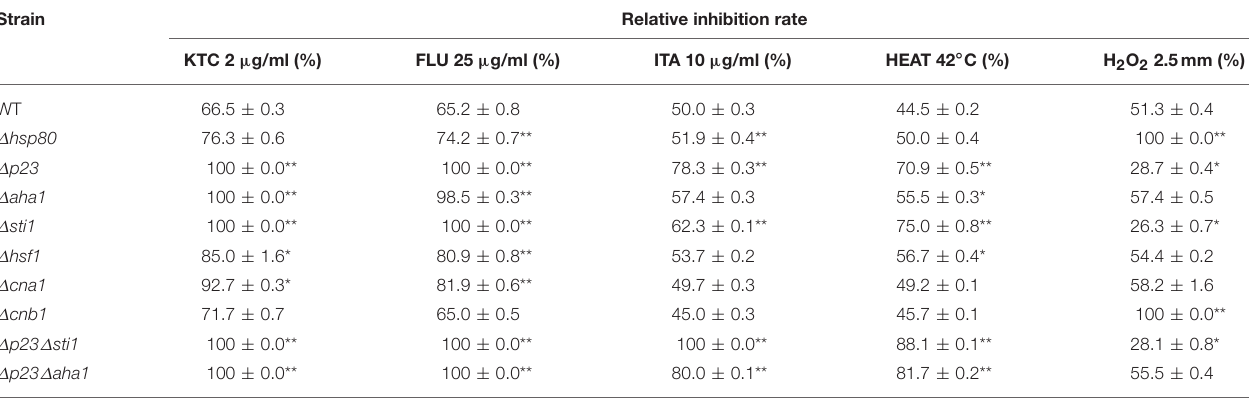
TABLE 2 | Relative inhibition rates of HSP90- related mutants by azoles, heat and H 2 O 2 . Strain Relative inhibition